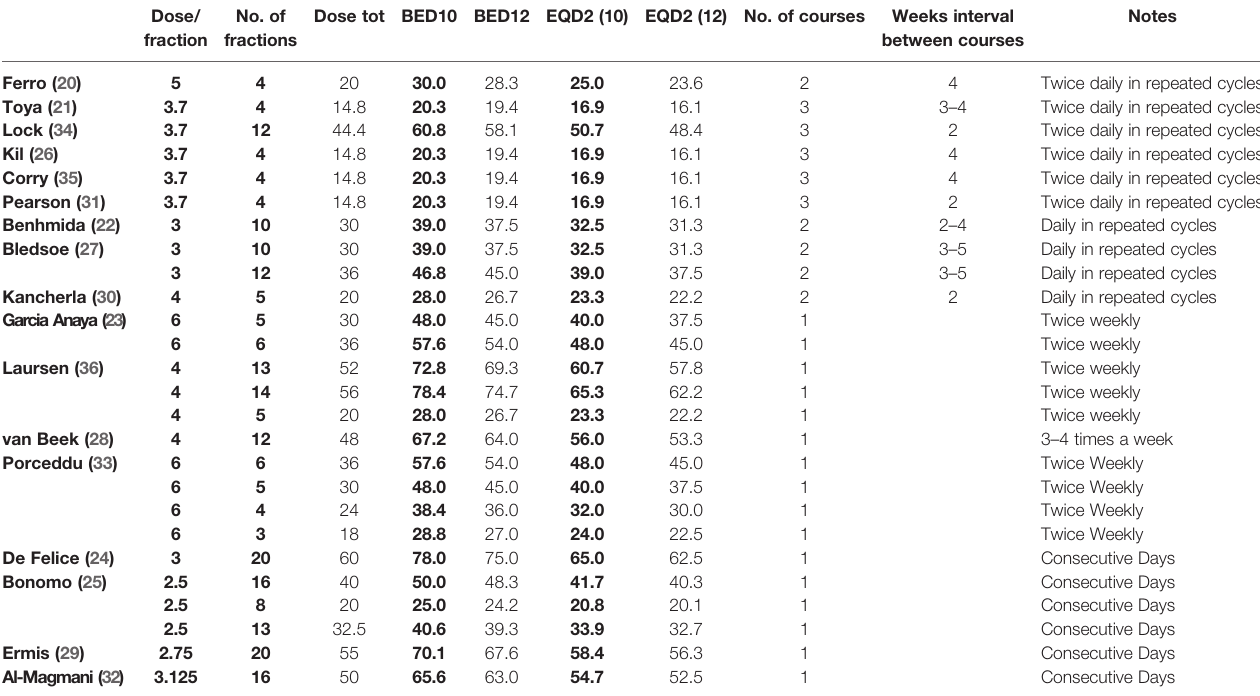
TABLE 2 | Details RT treatment and BEDs dose. Dose/